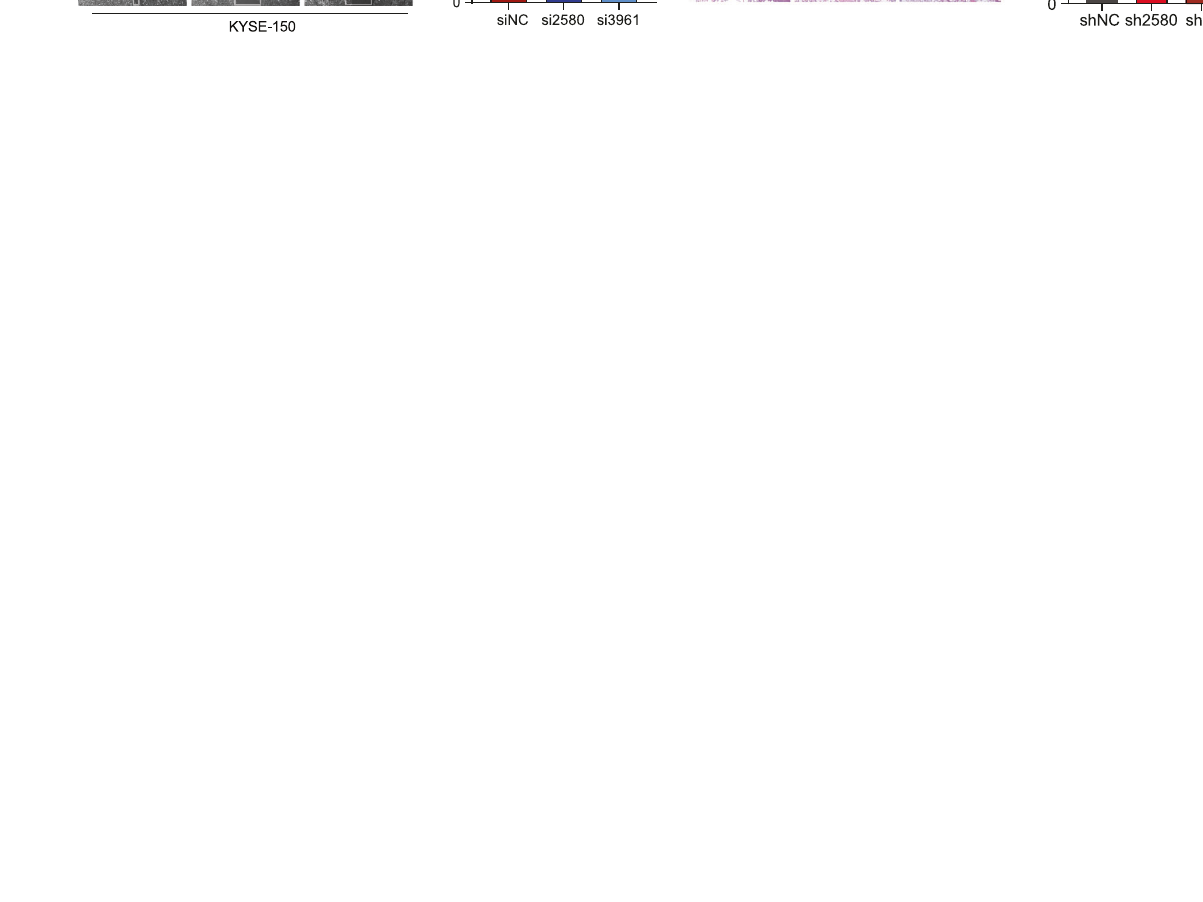
Cell Death and Disease (2023)